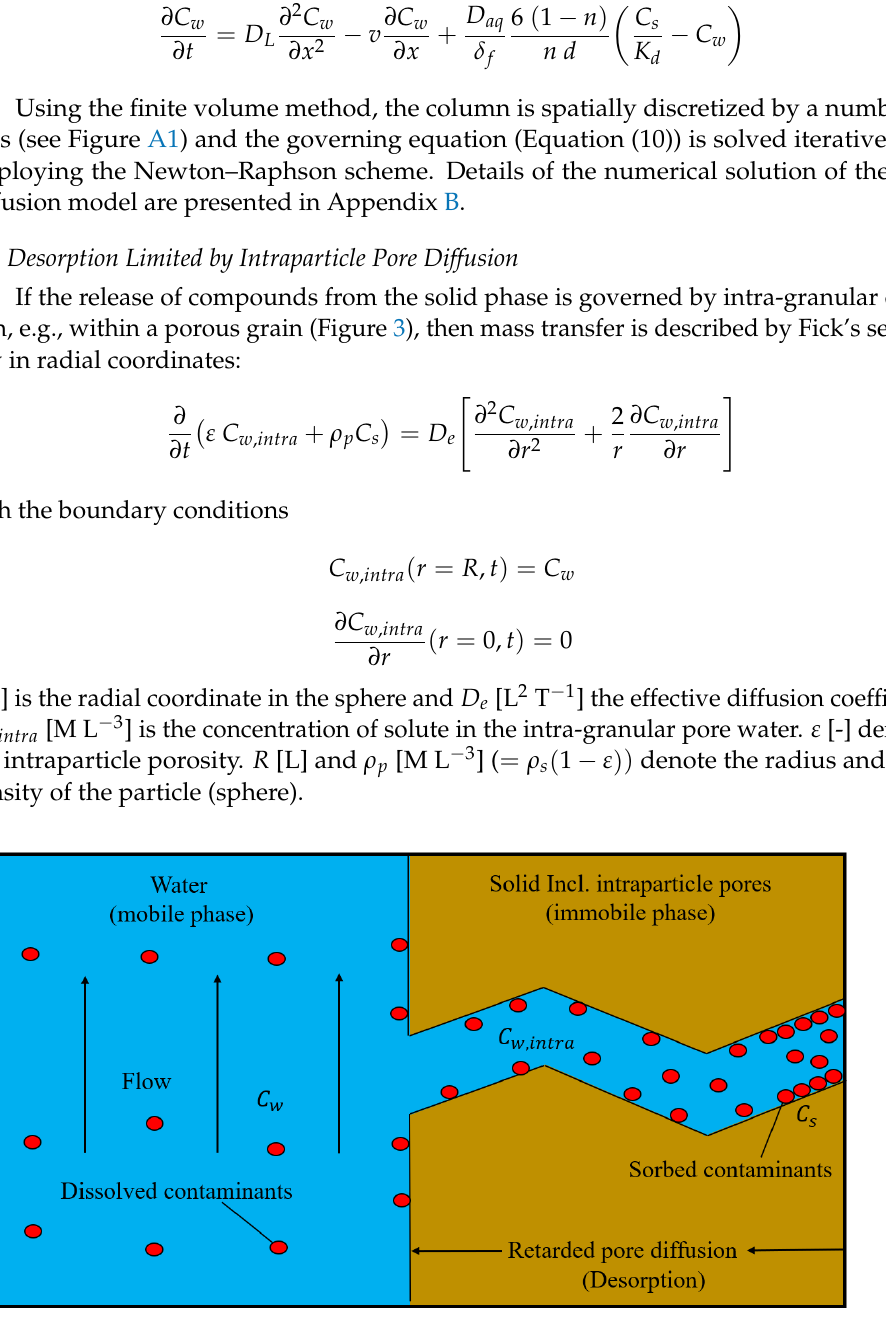
Figure 3. Scheme of mass transfer limited by intraparticle pore diffusion. For linear sorption with concentration independent distribution coefficients